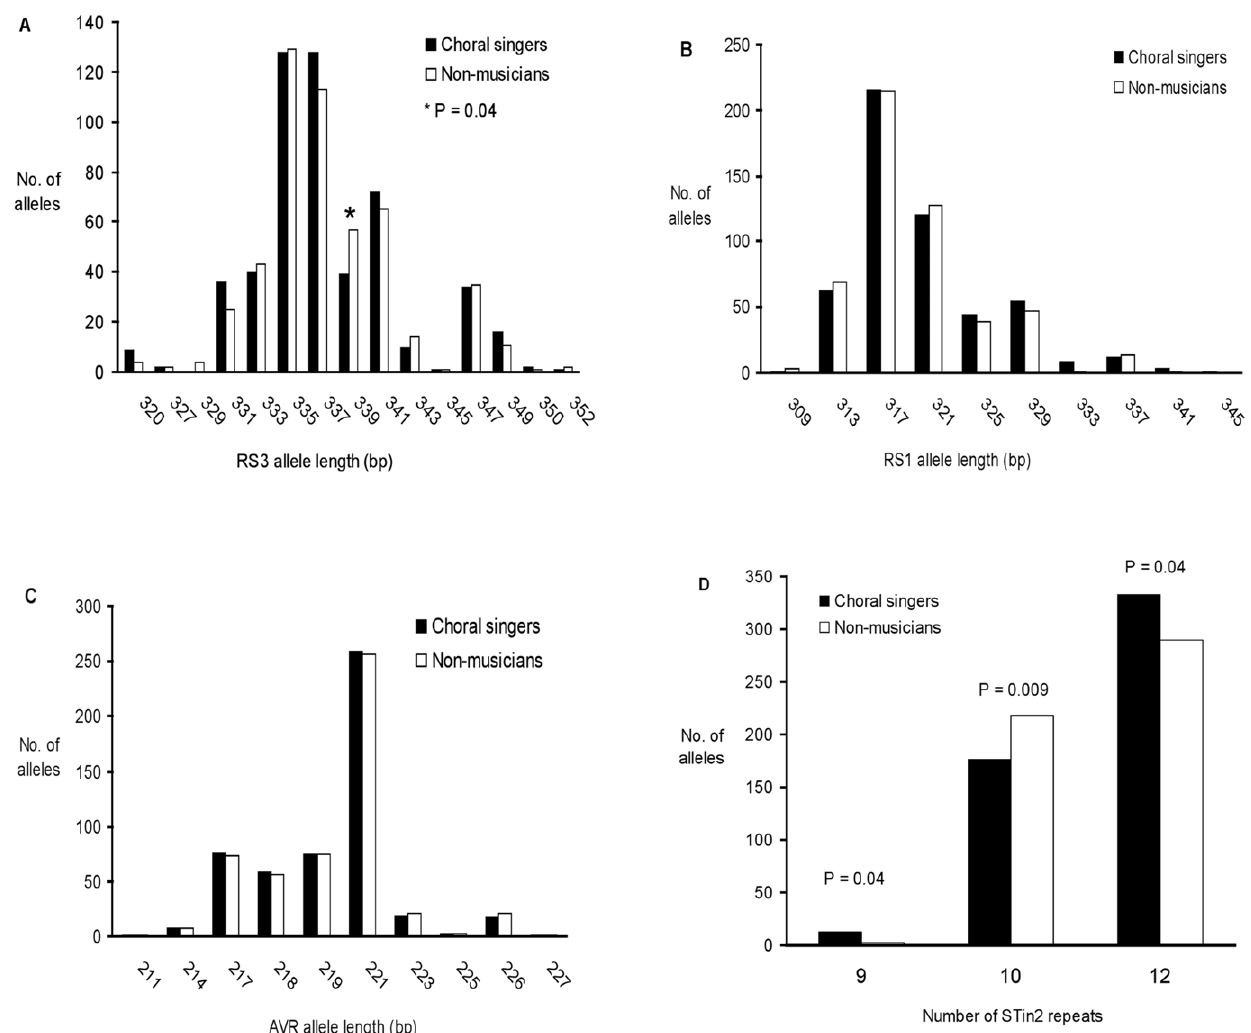
Figure 1. Allele frequencies in choral singers (n=261) and non musicians (n=258) for AVPR1A and SLC6A4 VNTRs. (A) RS3 (B) RS1 (C) AVR and (D)